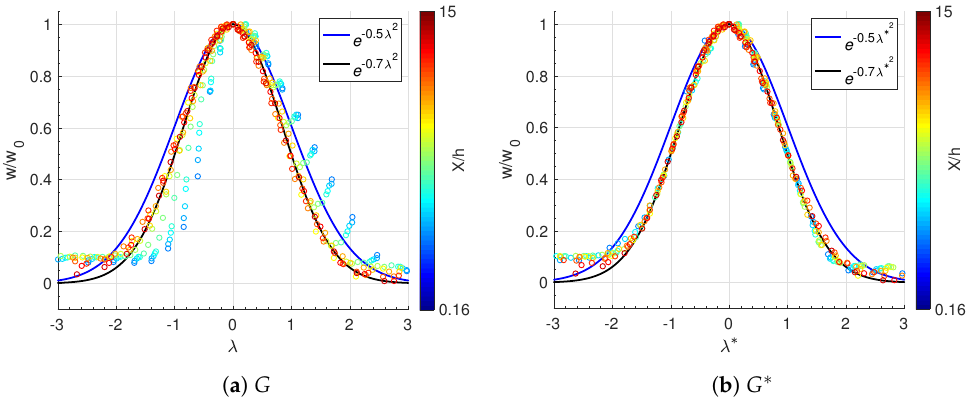
Figure 17. Gaussian self-similarity of the wake profiles at AOA = 8 ◦ according to EXP data.